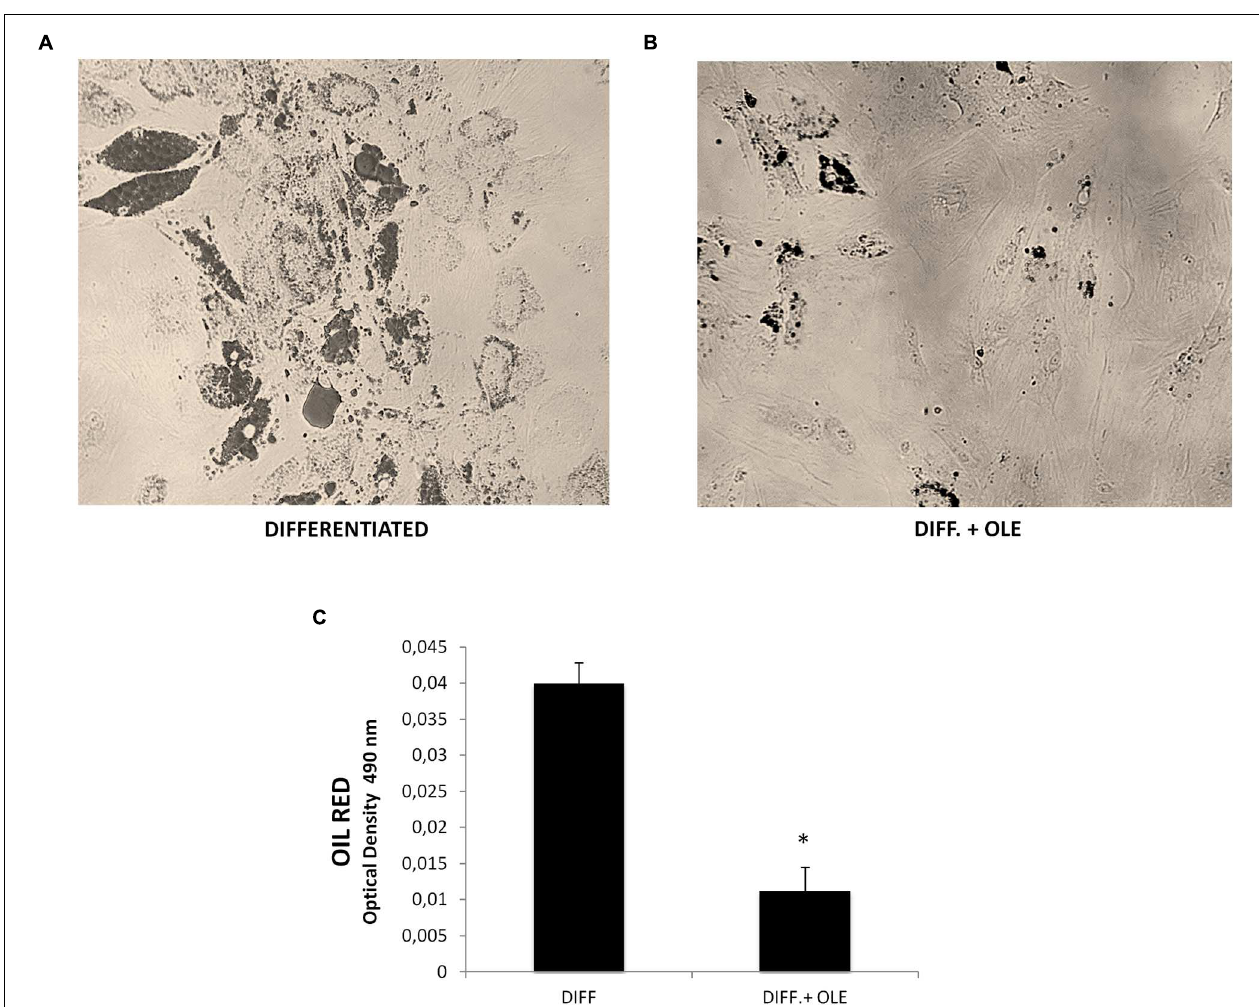
FIGURE 1 | (A,B) Lipid droplets accumulation measured by Oil red staining in differentiated cells (14 days of adipogenic differentiation) in presence (B) or absence of OLE (A) . Adipogenesis was measured as the relative absorbance (OD 490 nm) of Oil Red at day 14 after inducing adipogenesis as described in Section “Materials and Methods” (C) . All values are expressed as mean ± SEM of four experiments ( n = 4) in duplicate. (* P < 0.05 versus